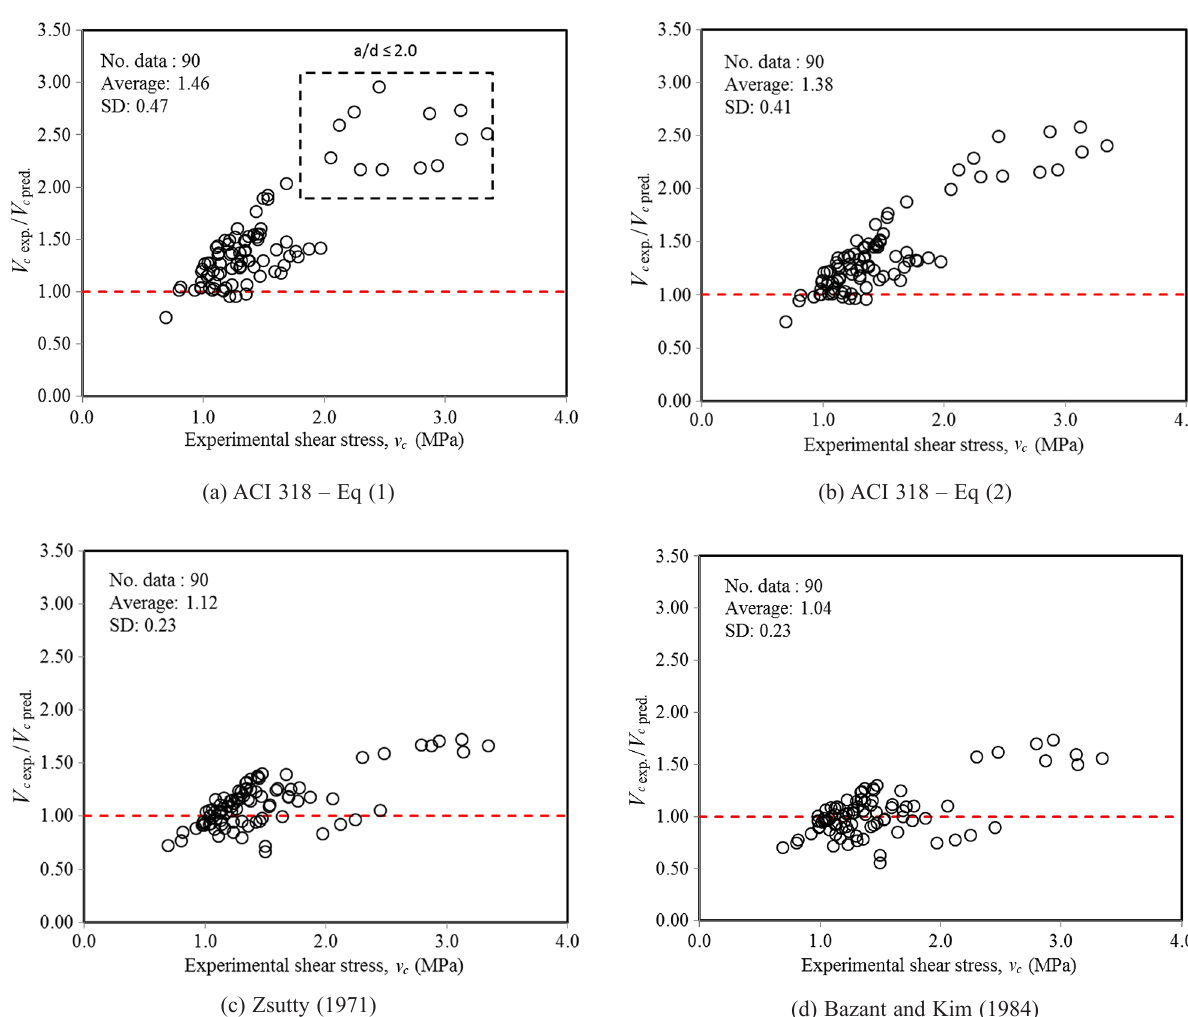
equations(c) Zsutty Fig. 11. Comparisons between experimental results and predicted values with existing